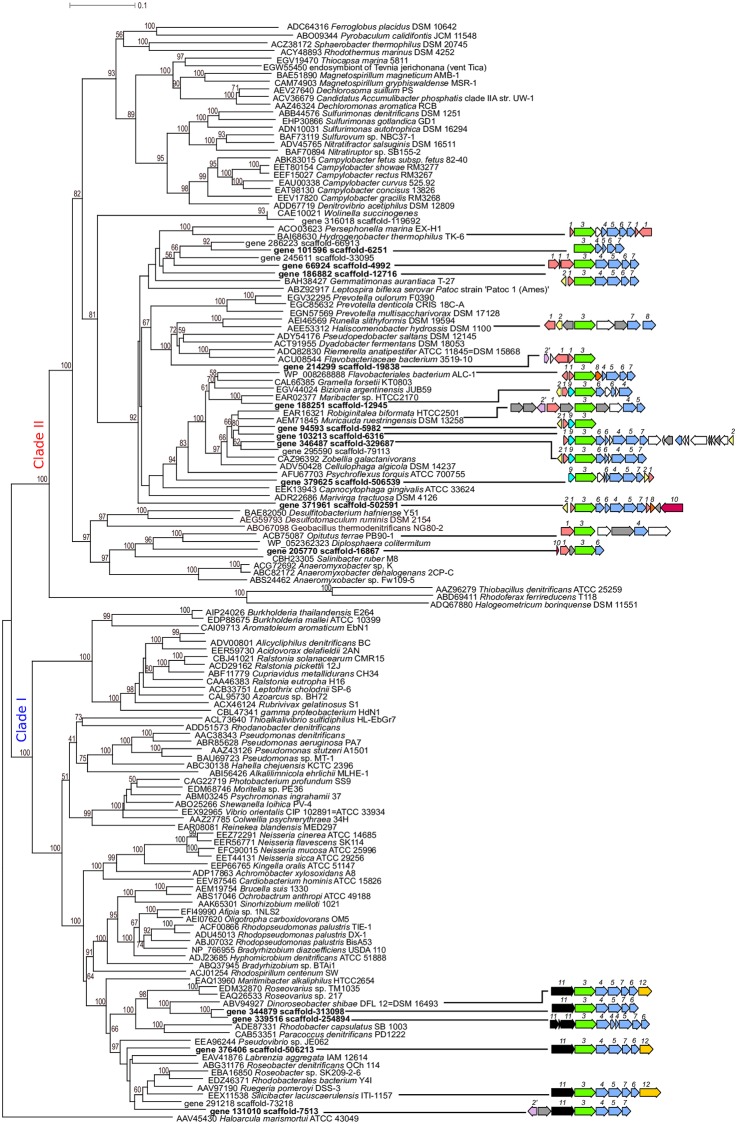
Phylogenetic tree of genomic/metagenomic NosZ sequences (left) and analysis of genomic context in scaffolds of a sediment metagenomic library from OR site (right), and related genomes.In the tree, genes from the metagenomic library are shown in bold, named with the gene number followed by the scaffold number. Bootstrap values are percent of 100 replications. In scaffold diagrams, numbers correspond to different genes, as assigned by RAST annotation system followed by manual curation. 1: c-type cytochrome; 2 and 2’: rrf2 and nnrR (Crp/Fnr family), respectively; 3: nosZ, 4: nosD; 5: nosF; 6: nosL; 7 nosY; 8: transmembrane protein; 9: sensory subunit of low CO2 induced protein; 10: Iron-sulfur (4Fe-4S) protein; 11: nosR; 12: nosX. Genes encoding for other proteins or hypothetical proteins are colored grey or white, respectively.